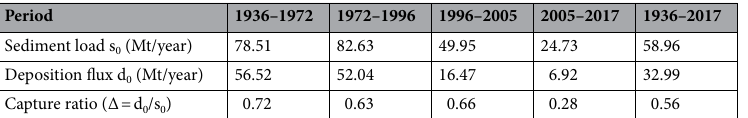
Table 4. Changes of deposition flux and sediment load in the estuary in different periods. Values were determined using a dry bulk density of 1.1 kg/m 3 .